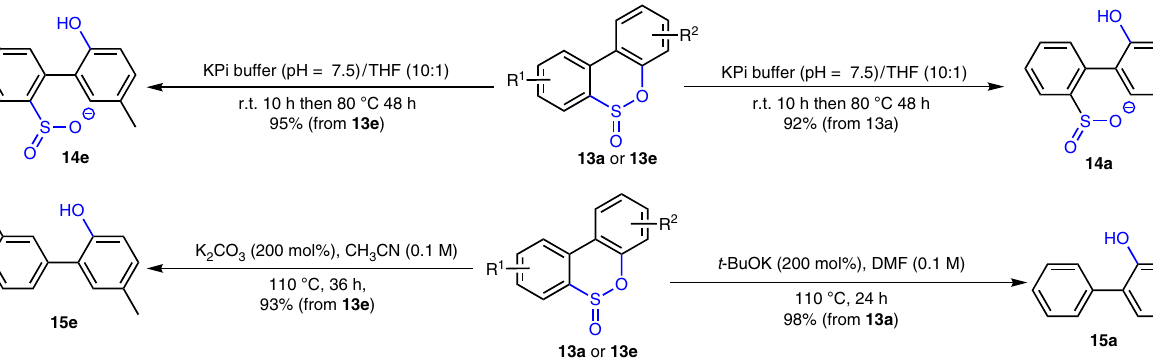
Fig. 3 Biomimetic desulfurization. In KPi buffer or in the presence of bases, sul fi nic esters ( 13a and 13e ) were smoothly converted to HBPS or 2-HBP derivatives. KPi buffer : potassium phosphate buffer.